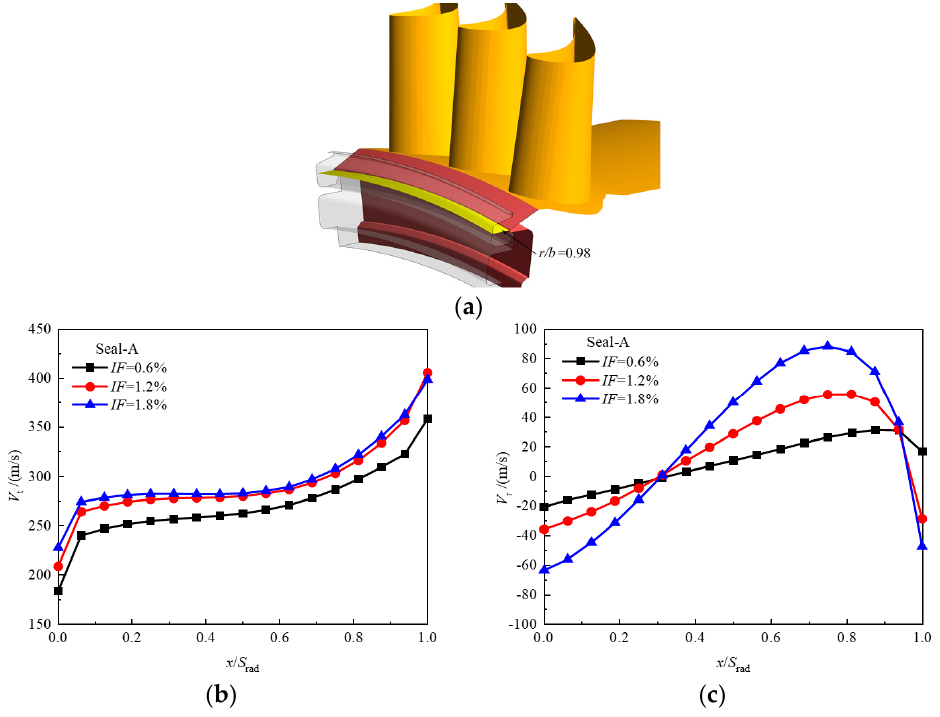
Figure 15. Time-averaged tangential and radial velocity variations along the axial direction at the middle section of the sealing cavity: ( a ) position of the section in the middle of the sealing cavity; ( b ) time-averaged tangential velocity; and ( c ) time-averaged radial velocity.